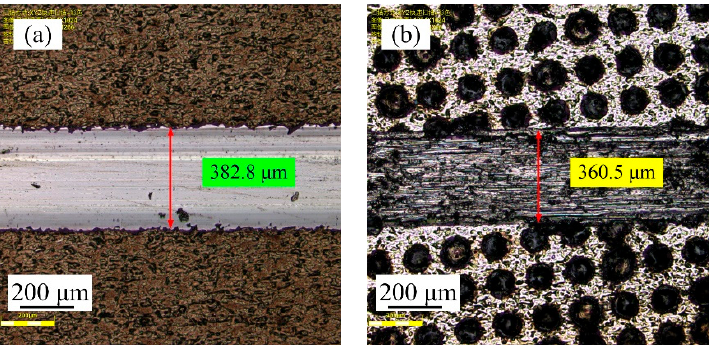
Figure 22. Wear scar width of samples before and after laser processing: ( a ) before laser processing; ( b ) after laser processing.